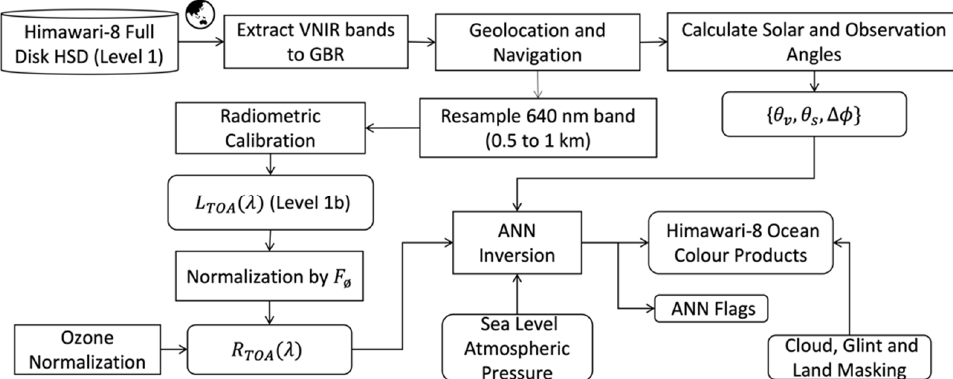
Figure 3. Himawari-8 Ocean Colour Processing flowchart. HSD refers to Himawari-8 Standard Data, Figure 3. Himawari ‐ 8 Ocean Colour Processing flowchart. HSD refers to Himawari ‐ 8 Standard GBR refers to Great Barrier Reef, VNIR refers to the Himawari-8 visible and near infrared bands (470, Data, GBR refers to Great Barrier Reef, VNIR refers to the Himawari ‐ 8 visible and near infrared 510, 640, and 856 nm), and ANN refers to Artificial Neural bands (470, 510, 640, and 856 nm), and ANN refers to Artificial Neural Network.